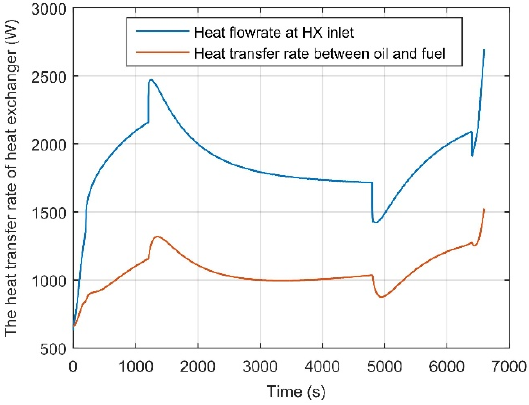
Figure 14. Heat transfer rate of heat exchanger.